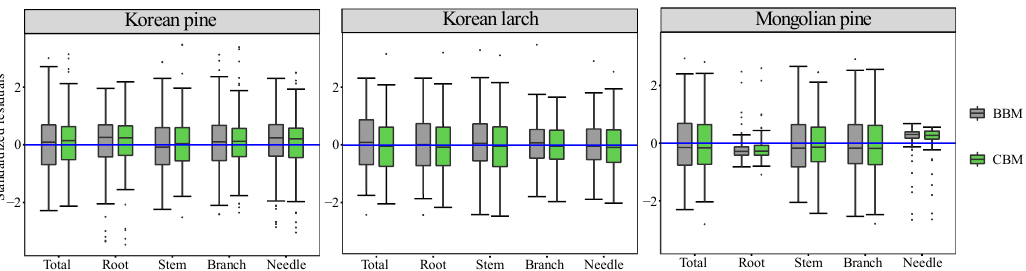
Figure 6. The box plot of standard residuals against the stand total and components of BBMs and CBMs for three conifer species. The boxes express the interquartile ranges. The upper and lower horizontal lines crossing the vertical bars represent the maximum and minimum standard residuals.